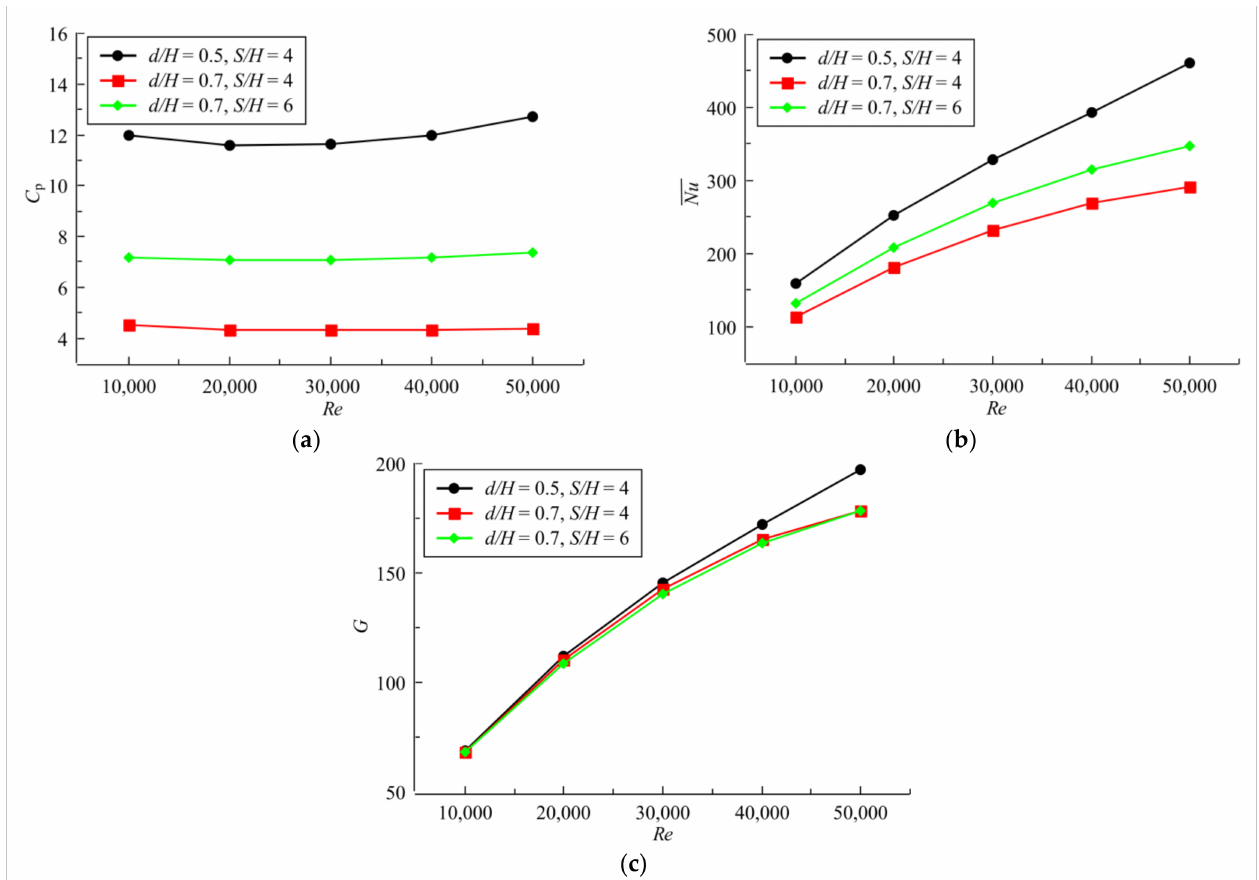
Figure 8. Effects of Re on the pressure loss coefficient, average Nusselt number, and comprehensive thermal coefficient of the quasi-leading-edge channel under steam cooling: ( a ) pressure loss coefficient; ( b ) average Nusselt number; ( c ) comprehensive thermal